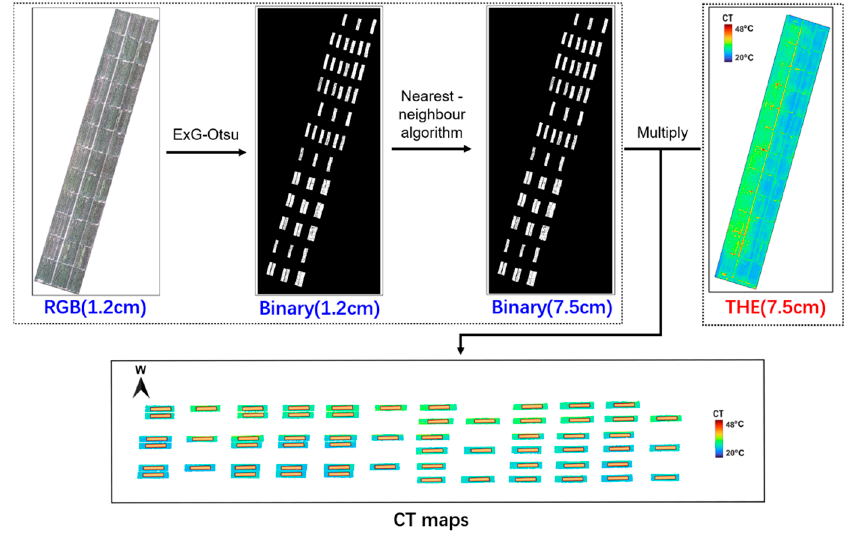
Figure 3. ExG-Otsu’s method of removing soil background through using UAV RGB and thermal infrared (THE) images. CT maps only display 60 tested plots (some plots were not further analyzed as mentioned in Section 2.1) in this study, and orange areas are the polygon layer that is used to extract canopy temperature from CT maps in the QGIS